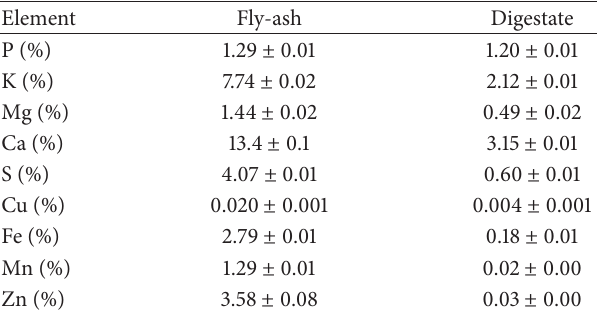
Table 2: Nutrient contents in the dry matter of ameliorative